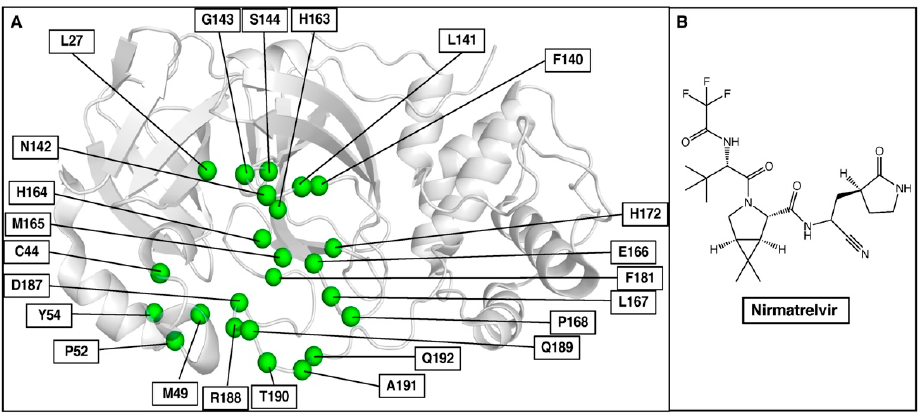
Figure 6. ( A ) Selected binding site residues in SARS-CoV-2 3CLpro to predict nirmatrelvir resistance mutations. ( B ) Chemical structure of